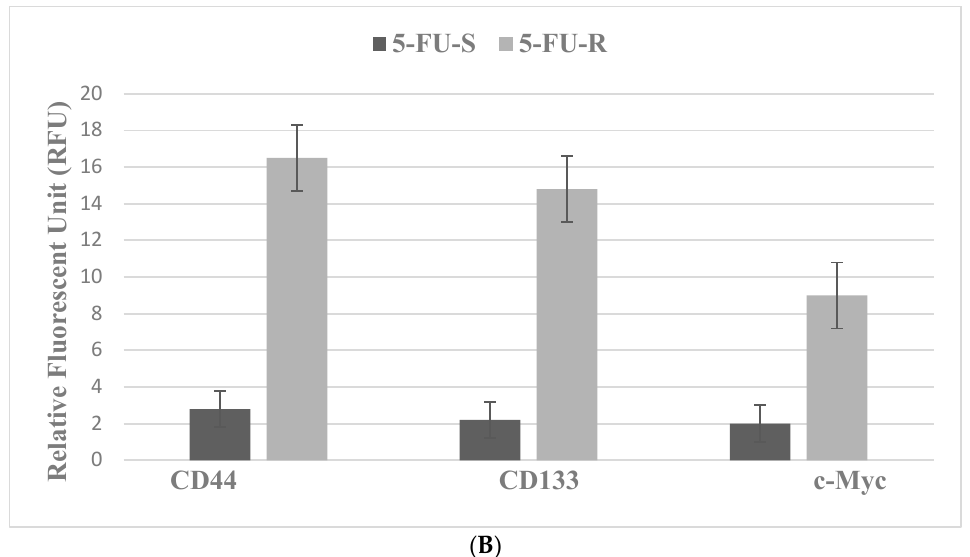
Figure 3. Status of tumor spheroid formation and stem cell marker expression in Mlh 1 /1638N COL model. ( A ) The tumor spheroid number is increased in the resistant 5-FU-R phenotype relative to the sensitive 5-FU-S phenotype. ( B ) The expression of CD44, CD133 and c-Myc is increased in the resistant 5-FU-R phenotype relative to the sensitive 5-FU-S phenotype. 5-FU, 5-fluro-uracil; CD44, cluster of differentiation 44; CD133, cluster of differentiation 133; c-Myc, cellular Myc.